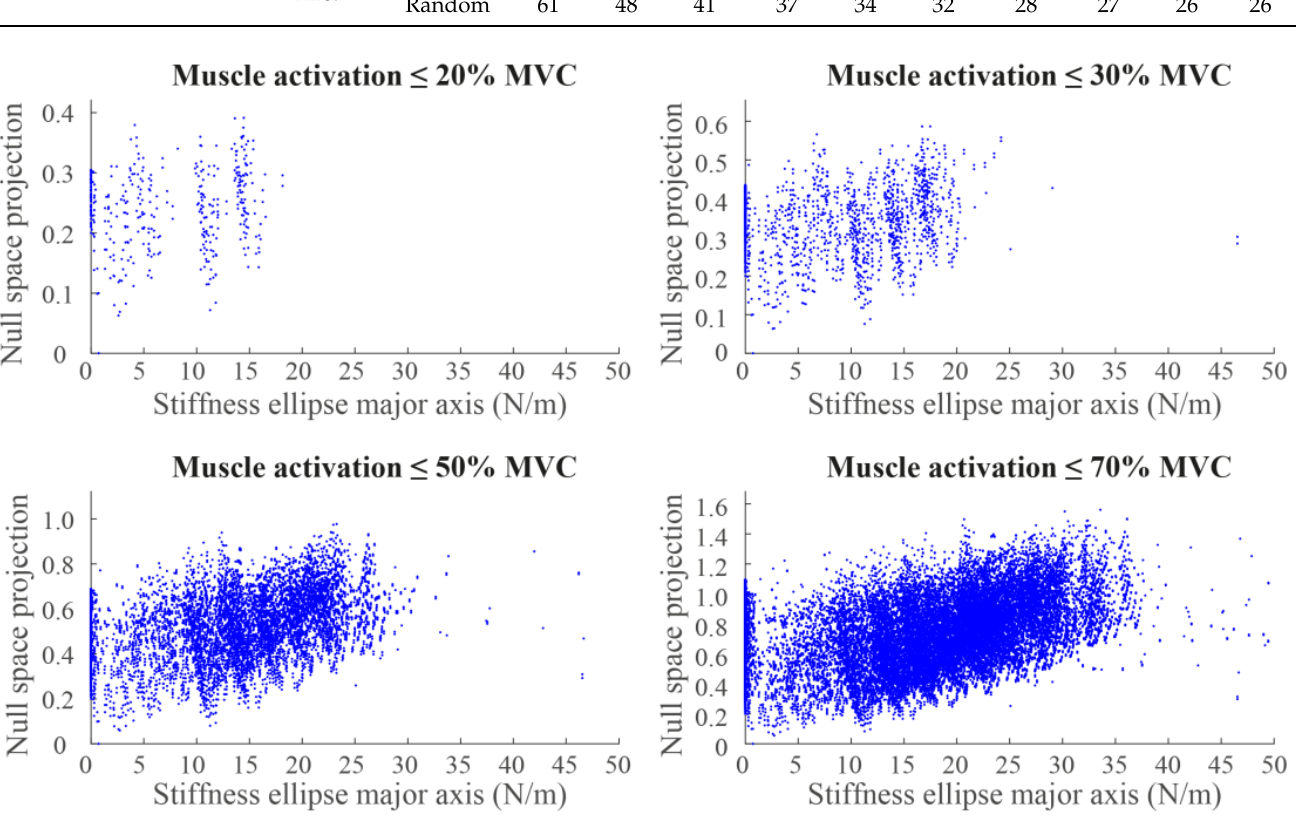
Figure 10. Examples of the relation between the major axis of the stiffness ellipse (x-axis) and the norm of the null-space projection of the muscle activations (y-axis) calculated on different sets of muscle activations simulated in a specific endpoint pose.